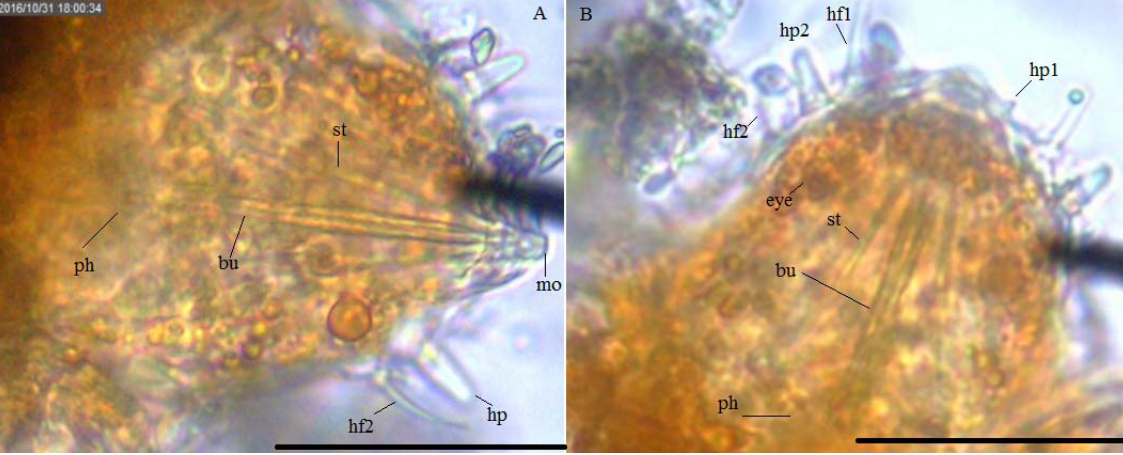
F IGURE 4. Structure of the E. testudo head and pharynx. Scale bar equals 25 μ m. (A) Ventral - mounted specimens. (B) Dorsal -mounted specimens. The ventral lobe extends on both sides of the buccal tube, but dorsal lods are short. Abbreviations: bu, buccal tube; C, claw; hf, head filaments; hp, head papila ; fu, furca; mo, mouth; st,